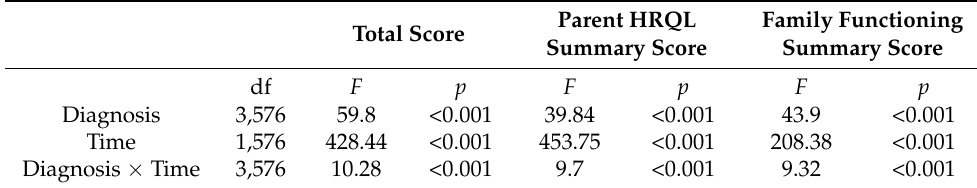
Table 2. Results from the repeated-measures